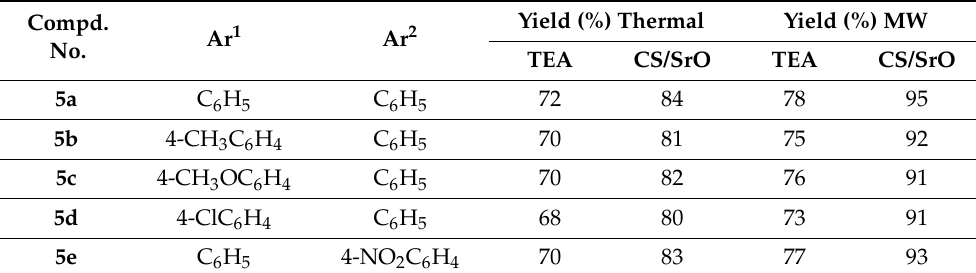
Table 1. Comparative yield percentage of thiadiazole derivatives 5a – e.